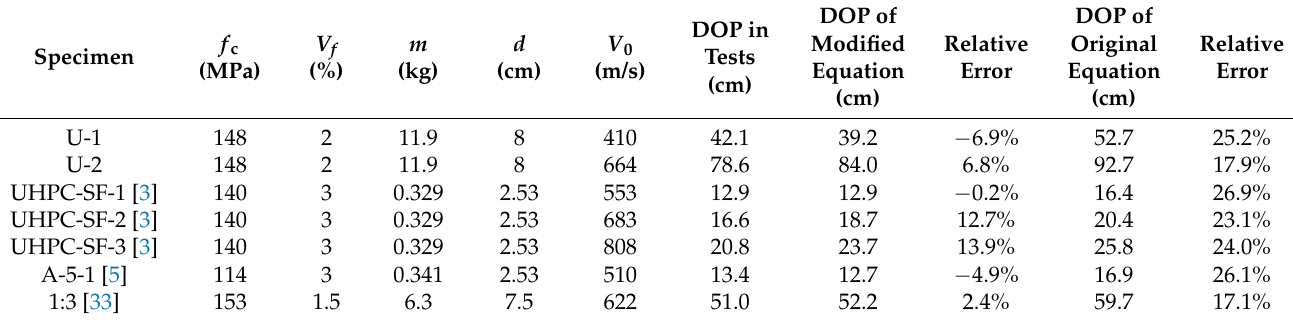
Table 8. Comparison of the DOPs between results of equation calculation and experimental results for different UHPC